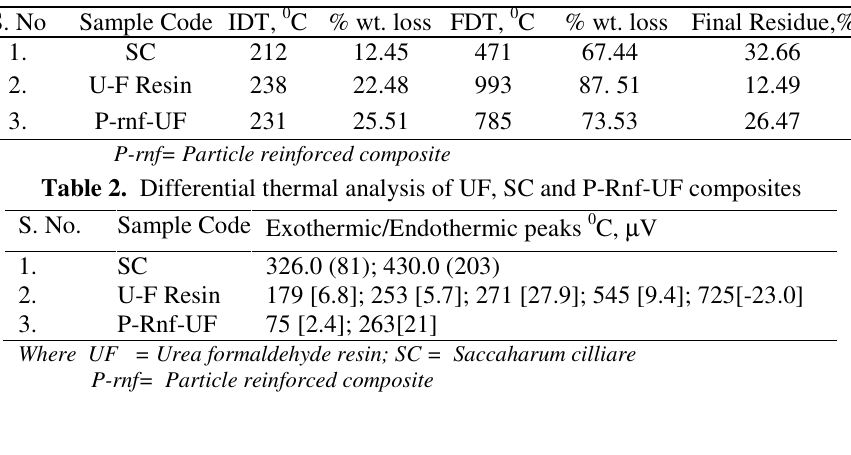
Table 1. Thermogravimetric analysis of UF, SC and P-Rnf-UF composites where UF = Urea formaldehyde resin; SC = Saccaharum Cilliare